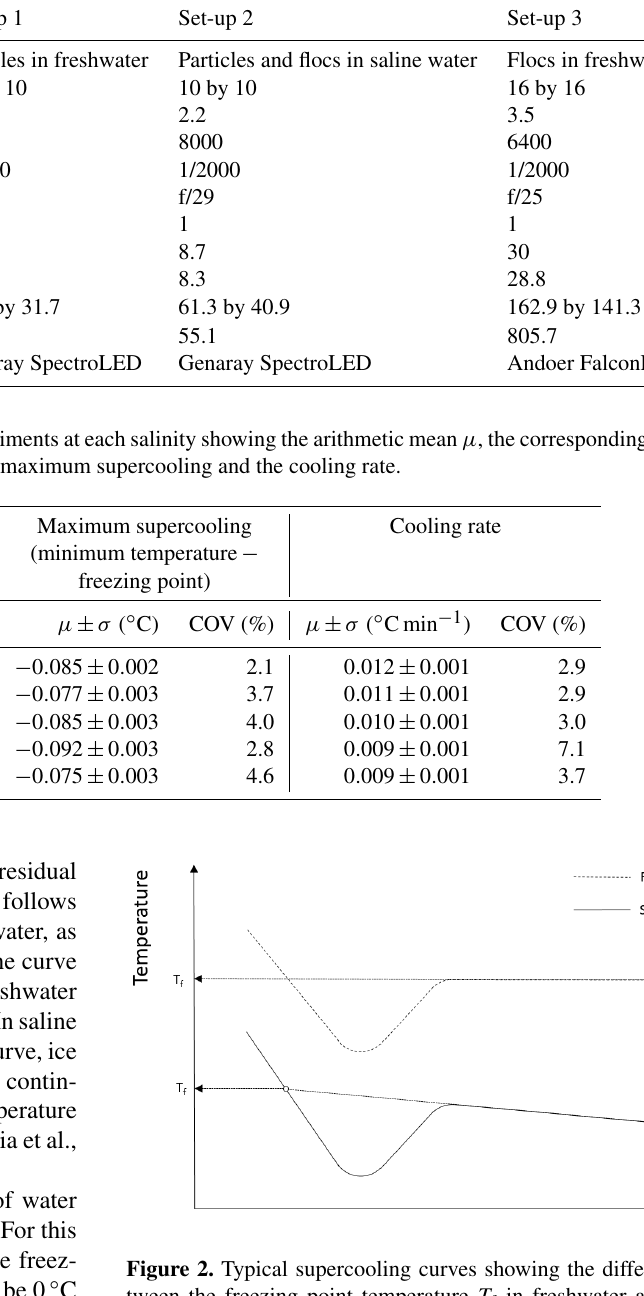
Table 1. Summary of camera and polarizer set-ups used in the experiments. Set-up number